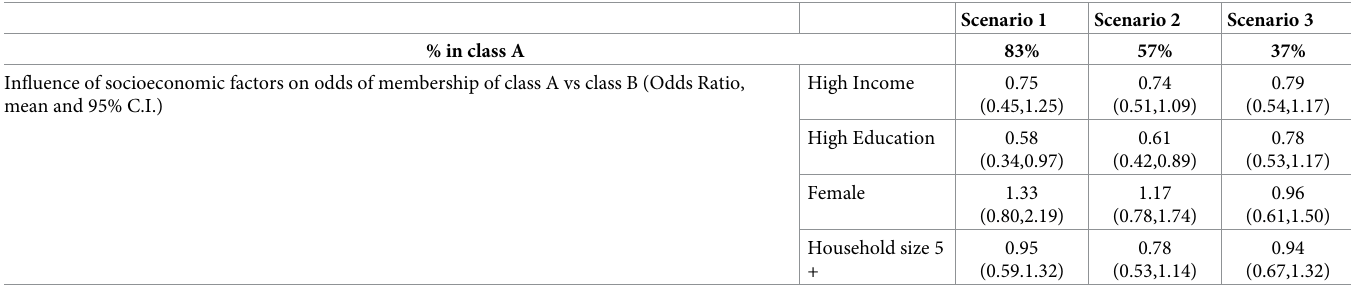
Table 6. Predictive impact of socioeconomic indicators on class membership in 2-class latent class